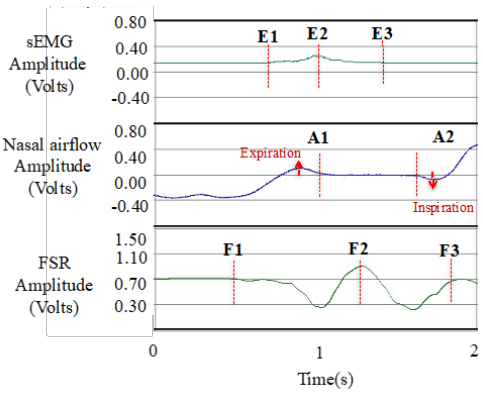
Figure 3. Swallowing and respiration signals from the sensors. (E3–E1): the duration of the submental muscle response, (A2–A1): the duration of the respiration pause, (F2–F1): the duration of the thyroid cartilage moving upward and forward to block the trachea, (F3–F2): the duration of the thyroid cartilage returning back to the original position. Table 1. Parameters of the respiration and swallowing signals.